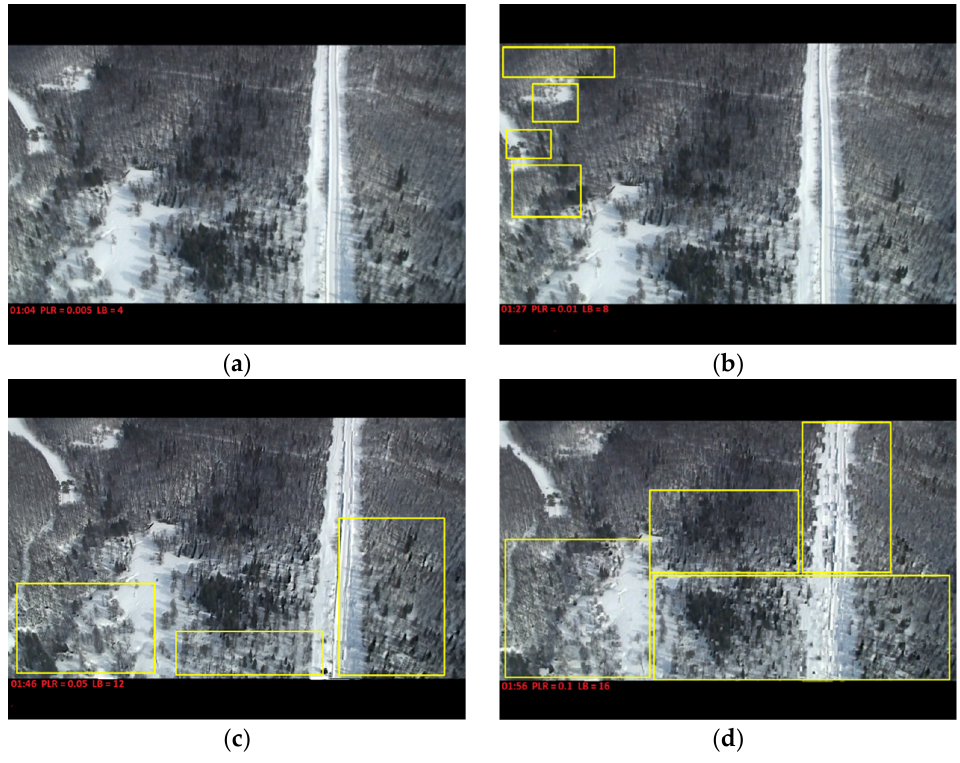
Figure 13. Influence of packet loss rate (PLR) and packet delay on the QoE. ( a ) PLR = 0.005 LB = 4; ( b ) PLR = 0.01 LB = 8; ( c ) PLR = 0.05 LB = 12; ( d ) PLR = 0.1 LB = 16. Table 2. Dependence of quality of experience on the packet loss rate